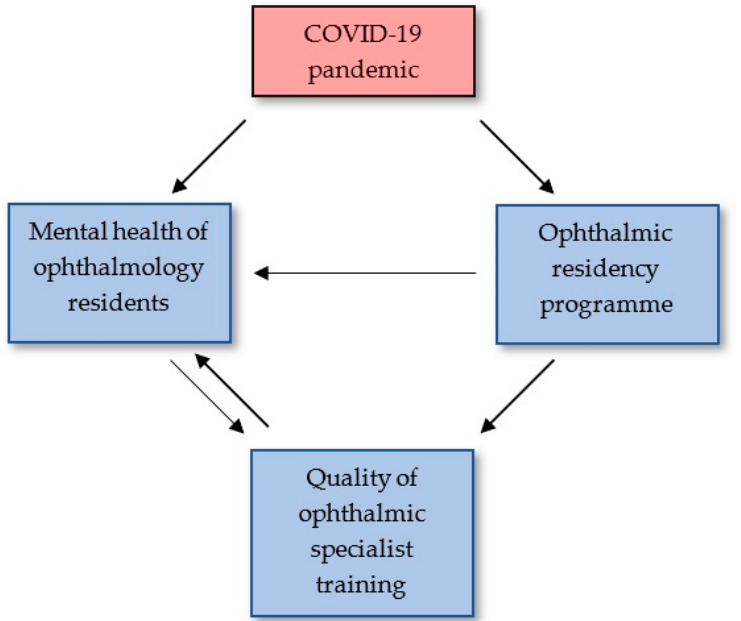
Figure 2. Diagram illustrating the impact of the COVID-19 pandemic and the interaction of the mental health status and ophthalmology residency programs.